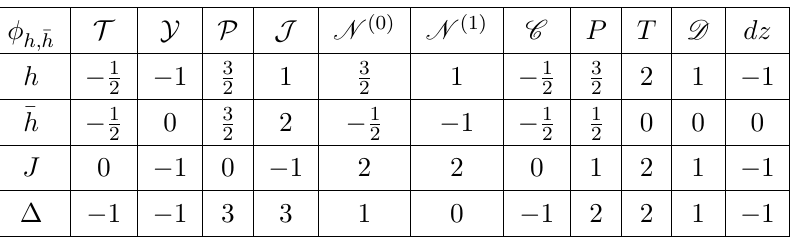
Table 1 . Conformal weights ( h,